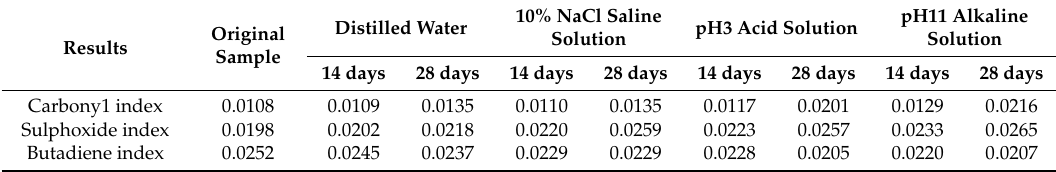
Table 4. Group indices of SBS modified asphalt before and after water solute immersion.